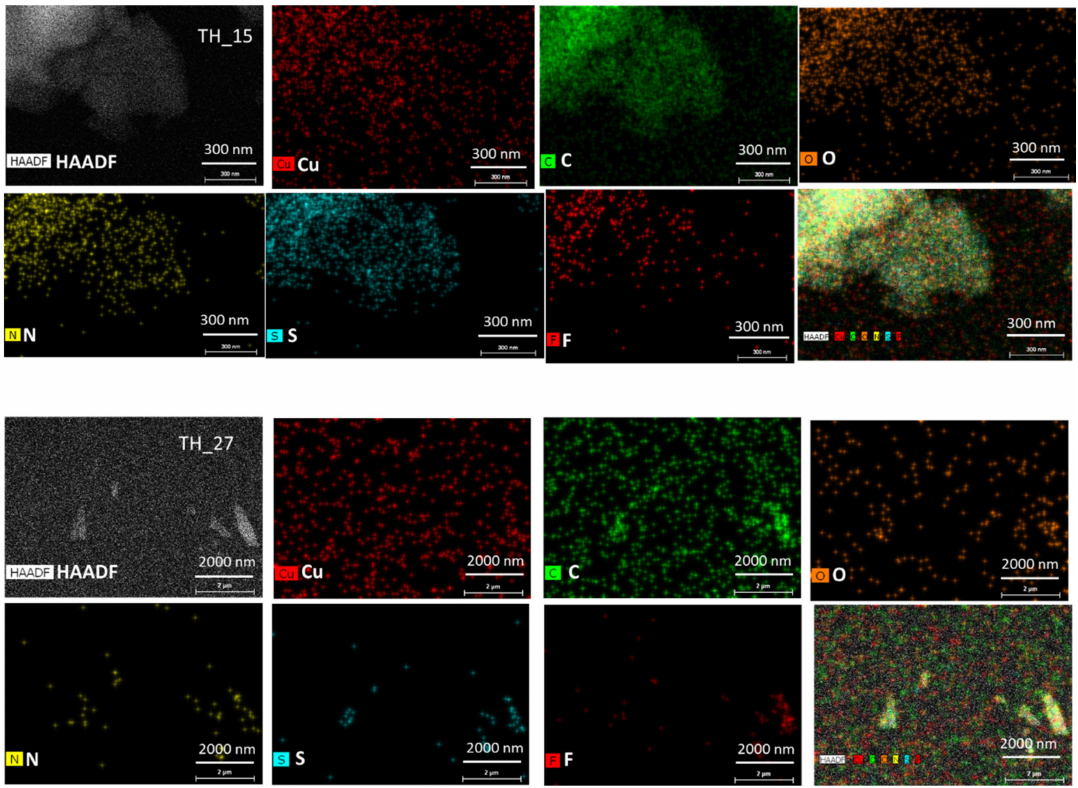
Figure 1. Scanned area and EDS mapping of TH-15 ( up ) and TH-27 ( down ) peptide compound shows presence of presence of C, N, S, O (from the molecule) and F (impurities). Cu signal is homogeneously distributed and is an artifact due the TEM sample grid being made of copper. Top left corner image shows the high annular dark field image (HAADF) of the observed